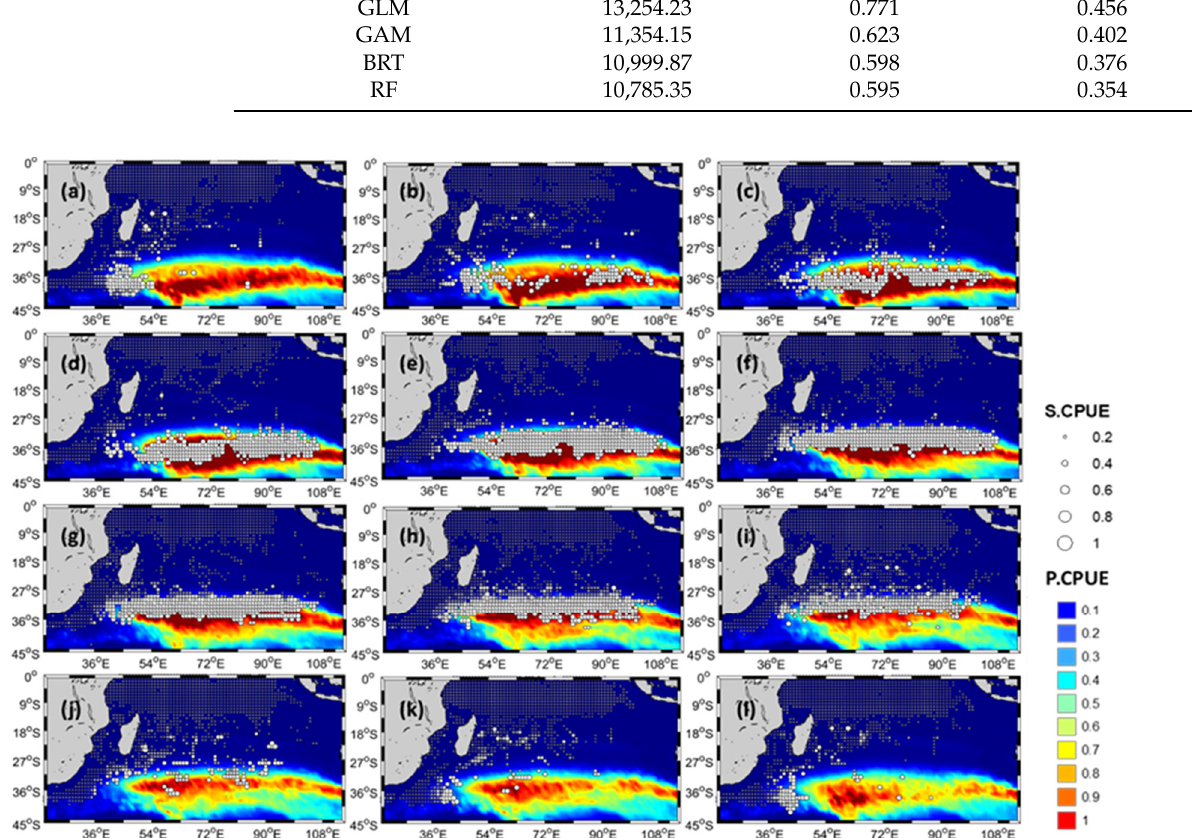
Table 8. Evaluation of single-algorithm models with full data set for ensemble model construction. Single-Algorithm Model